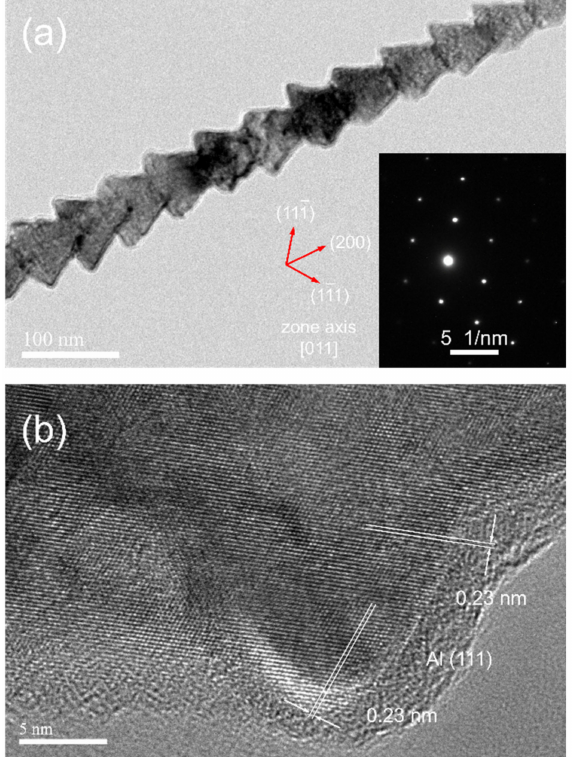
Figure 11. ( a ) TEM image, SAED pattern and ( b ) HRTEM image of a fish-bone-like Al nanowire electrodeposited at − 1.6 V/25 ◦ C for 120 s with a 2 mm–thick insulation ring (inner diameter was 6